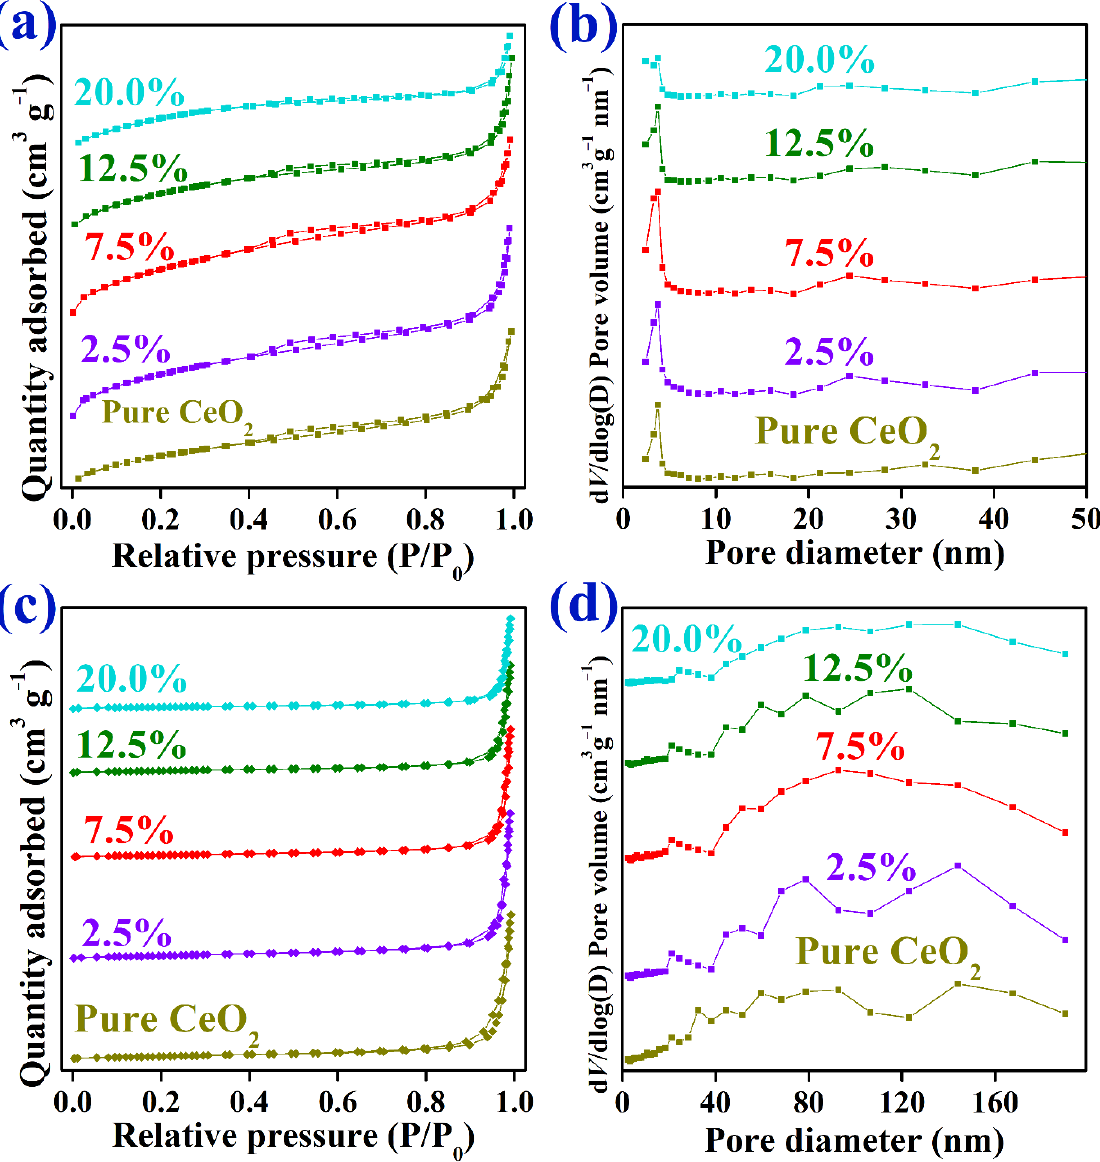
Figure 2. N 2 adsorption/desorption isotherms and BJH pore-size distributions of calcined ( a , b ) and reduced ( c , d ) Ni@CeO 2 catalysts prepared at different Ni-loadings (2.5, 7.5, 12.5, and 20 wt%).